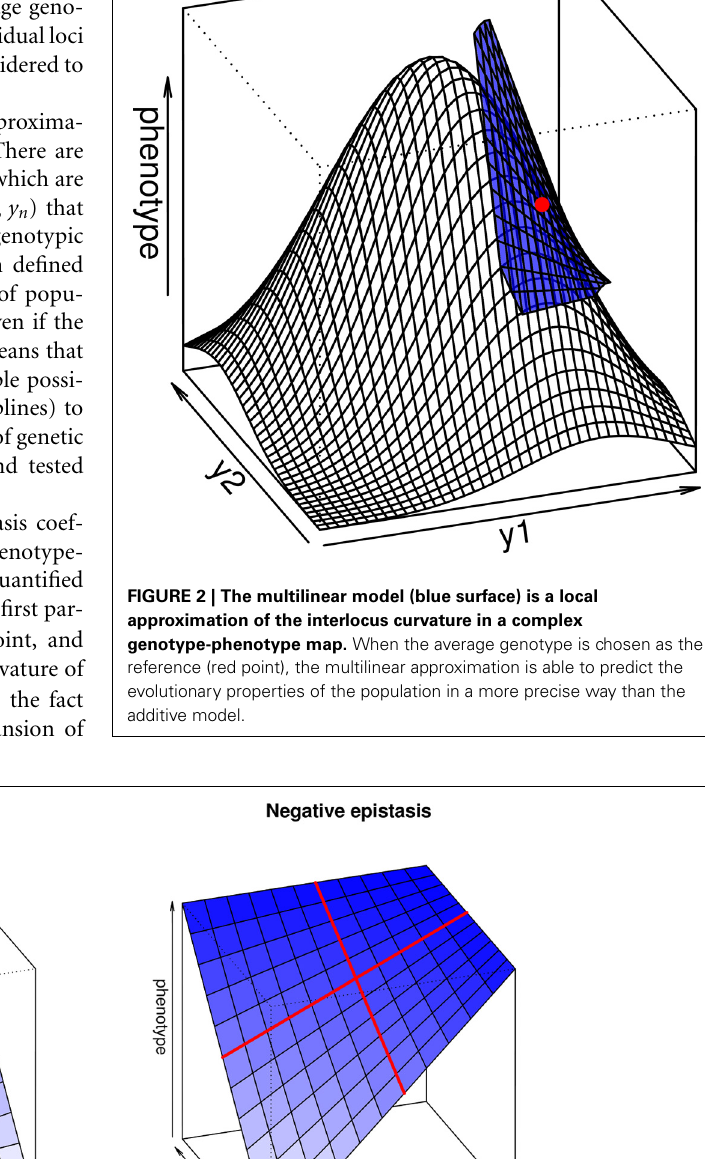
FIGURE 1 | Multilinear genotype-phenotype maps for two loci, illustrating positive (synergistic) and negative (antagonistic) epistasis. y 1 and y 2 represent the genotype values at both loci. The red lines